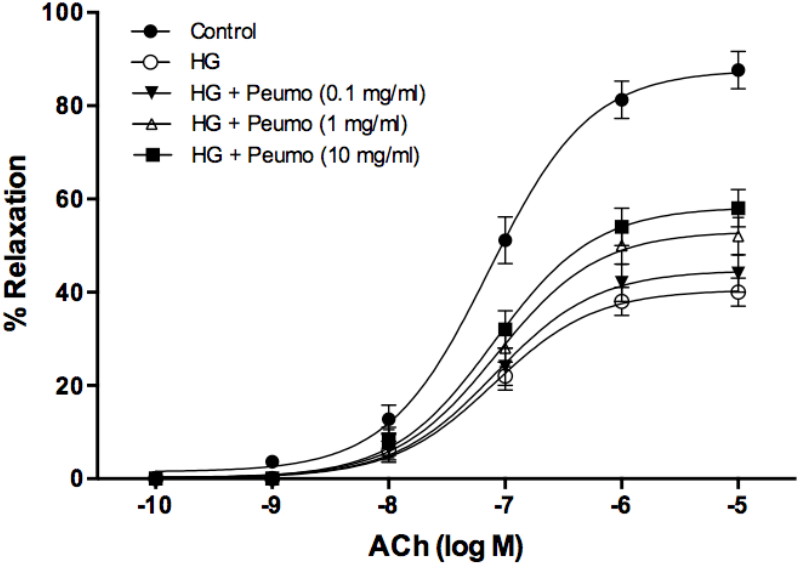
Figure 4. Vasoprotector effect of peumo extract on aortic rings. Concentration-response curves to ACh (0.0001–10 µ M) in precontracted rings with 0.1 µ M of PE. Before performing the concentration- response curves to ACh, the rings were pre-incubated for 3 h under the following conditions: control, high glucose (5 mM D-glucose) (HG), and in the presence of HG plus extracts of peumo (0.1, 1, and 10 mg/mL) (Ca3 stage). The results (mean ± SE) are expressed as a percentage of relaxation (% relaxation).